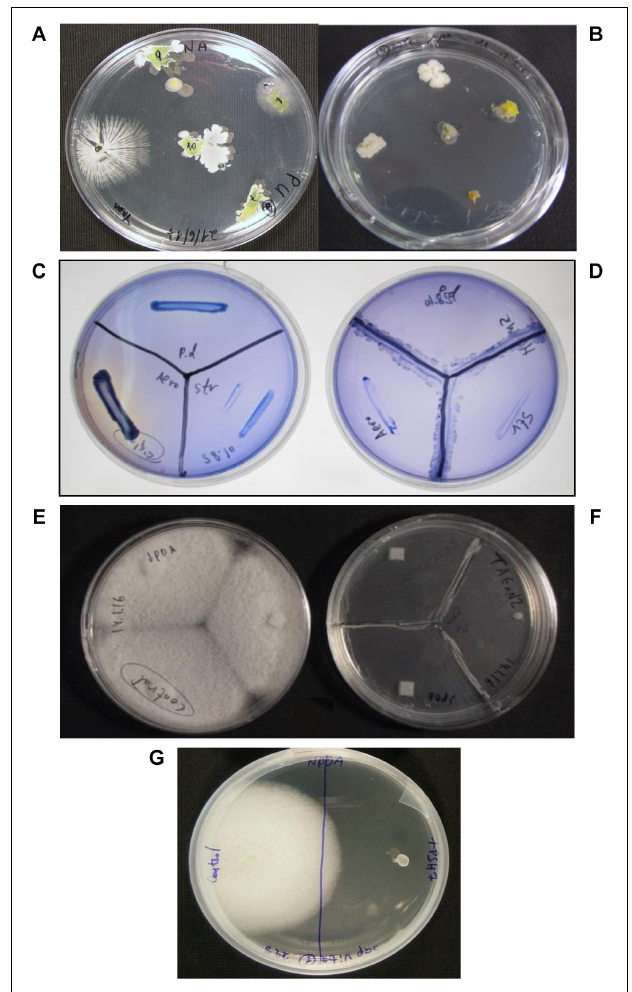
FIGURE 1 | Isolation and bioactivity assessment of endophytes from algae. Endophytes were isolated by placing sterilized algal pieces on growth media in petri plates and incubating at 25 ◦ C until initiation of bacterial and fungal growth from the algal tissue (A,B) . The endophytes were then tested in vitro in bioactivity assays (C–F) by growing them on supporting growth media in a “Y” shape prior to placing the pathogens as shown in (D,F) . Inhibition was measured in comparison to controls (no endophytes) (C,E) . Pathogen viability test (G) exhibited temporary inhibition or loss of viability of the pathogen. This test was performed by transferring the pathogen from the bioactivity test to a new growth plate in the absence of the endophyte. Regrowth of the pathogen after 3 days of incubation indicated inhibition by the endophyte, while no growth ( G, right) indicated loss of viability. Endophytes were tested for activity against the oomycete pathogen: S. parasitica ( F,G, right) and three bacterial pathogens: P. damselae, Strep. iniae and A. salmonicida (D) . Control plates: pathogens in the absence of the endophytes ( C,E,G,